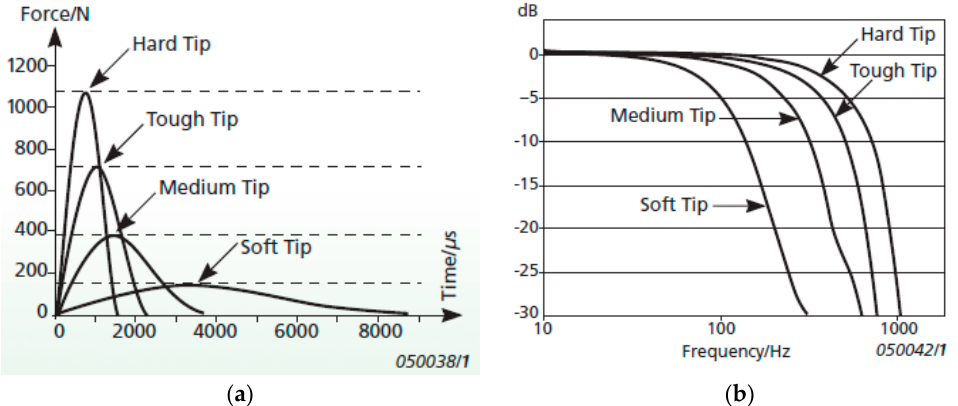
Figure 2. Mesh on the CLT panel. Five accelerometers (red dots) were placed at points 10, 11, 13, 17, and 24), whereas the hammer was moved around all nodes, except on the short edges.